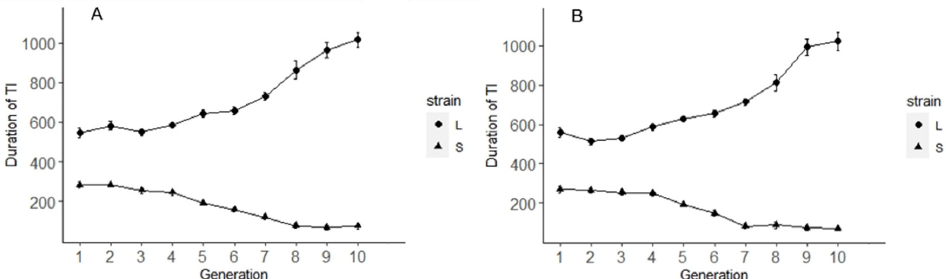
Figure 2. The duration of TI of SPWs from L-stain and S-strain. ( A ) The duration of TI of male SPWs from F1 to F10. ( B ) The duration of TI of female SPWs from F1 to F10. Circle—L-strain; triangle—S- strain.